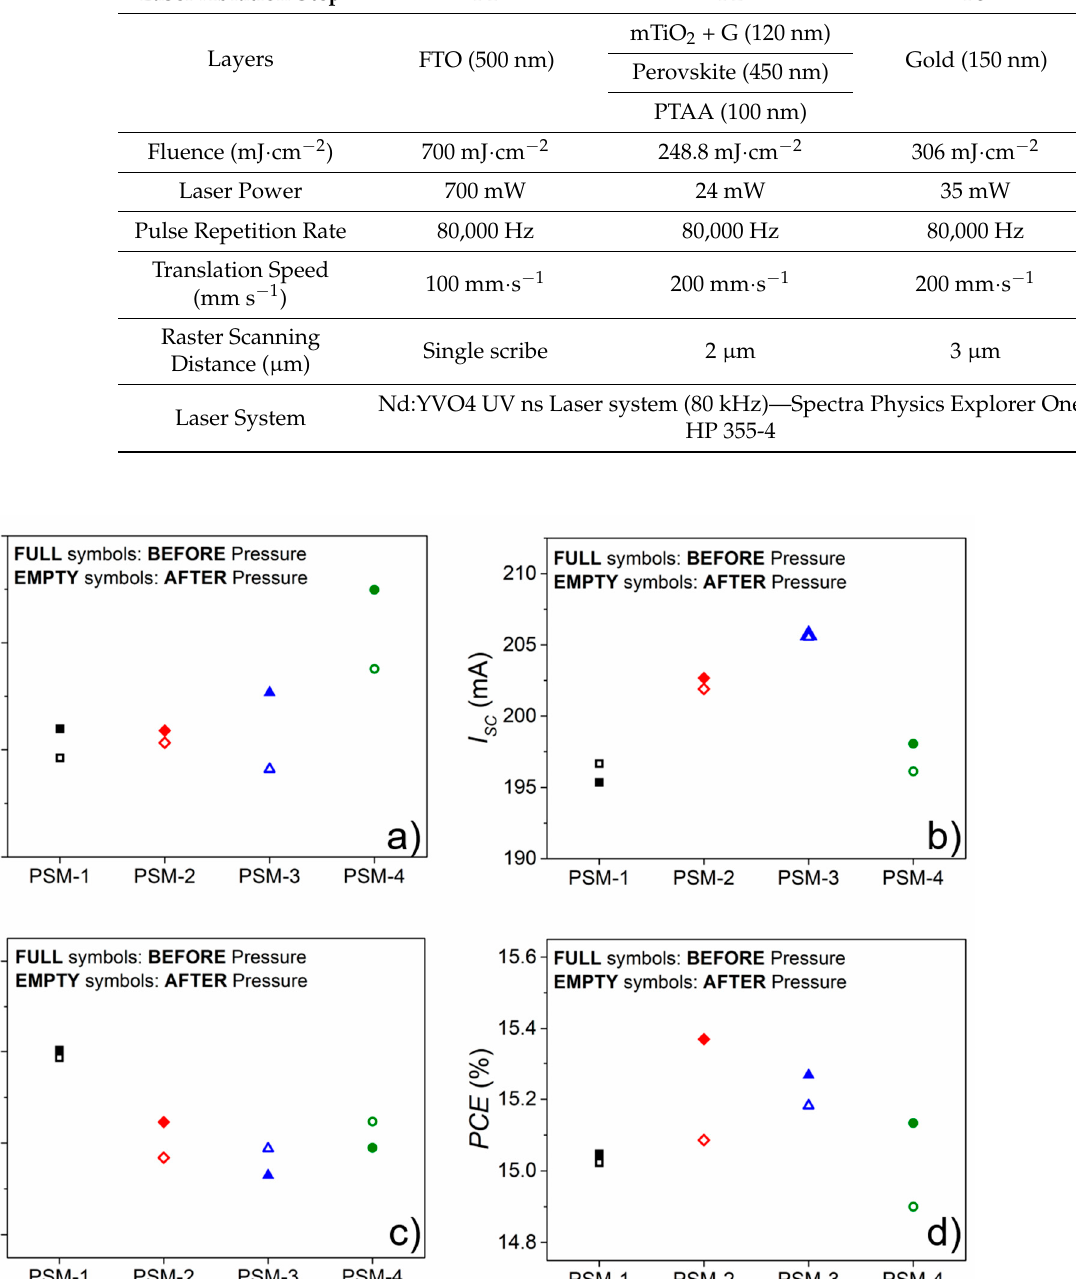
12 of 15 Table 3. Parameter sets optimized for each laser process (P1, P2, P3) employed in the PSM fabrica-